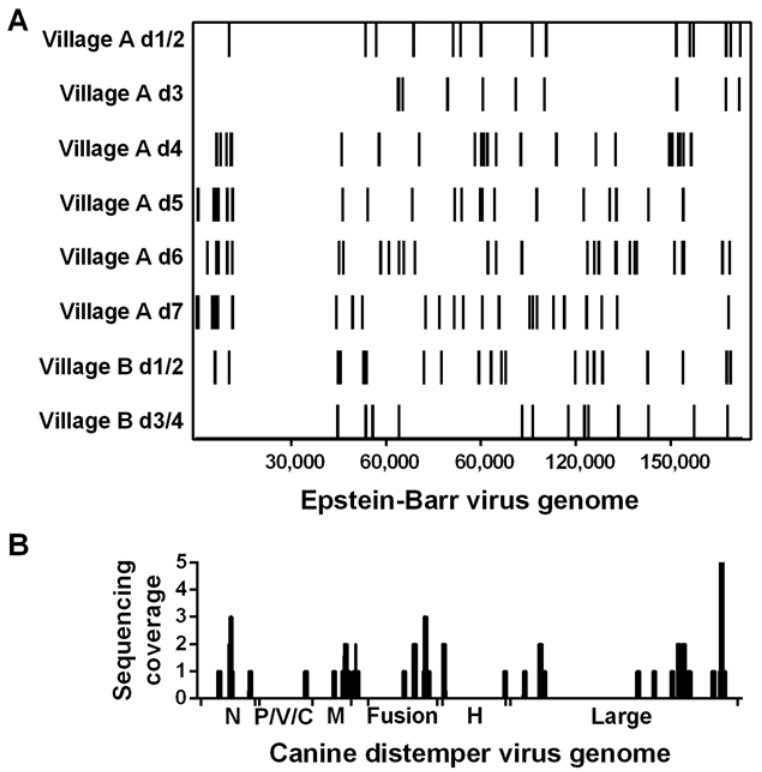
Fig 4. Sequencing reads from mosquito bloodmeals collected in Liberia aligning to Epstein-Barr virus (EBV) and canine distemper virus (CDV) genomes. Bloodmeals from indoor resting mosquitoes were collected from two villages in northern Liberia and sequenced. (A) All pooled M-DBSs contained 100bp reads aligning to EBV and (B) one pool of M-DBSs (Village A d7) contained 100bp reads aligning to CDV. N, nucleoprotein; P/V/C, phospho- and nonstructural V and C proteins; M, matrix protein; H, hemagglutinin protein.